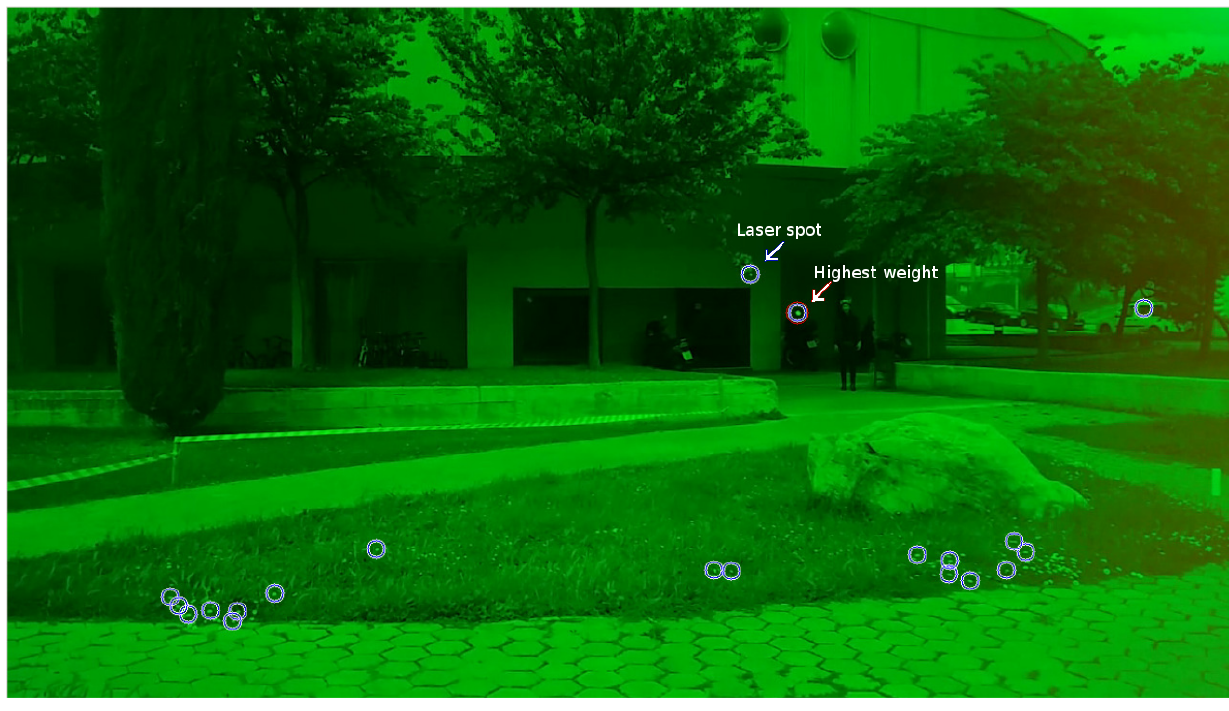
Figure 4. Detected laser spot candidates: the location of the true laser spot and the location of the candidate with the highest weight are marked with